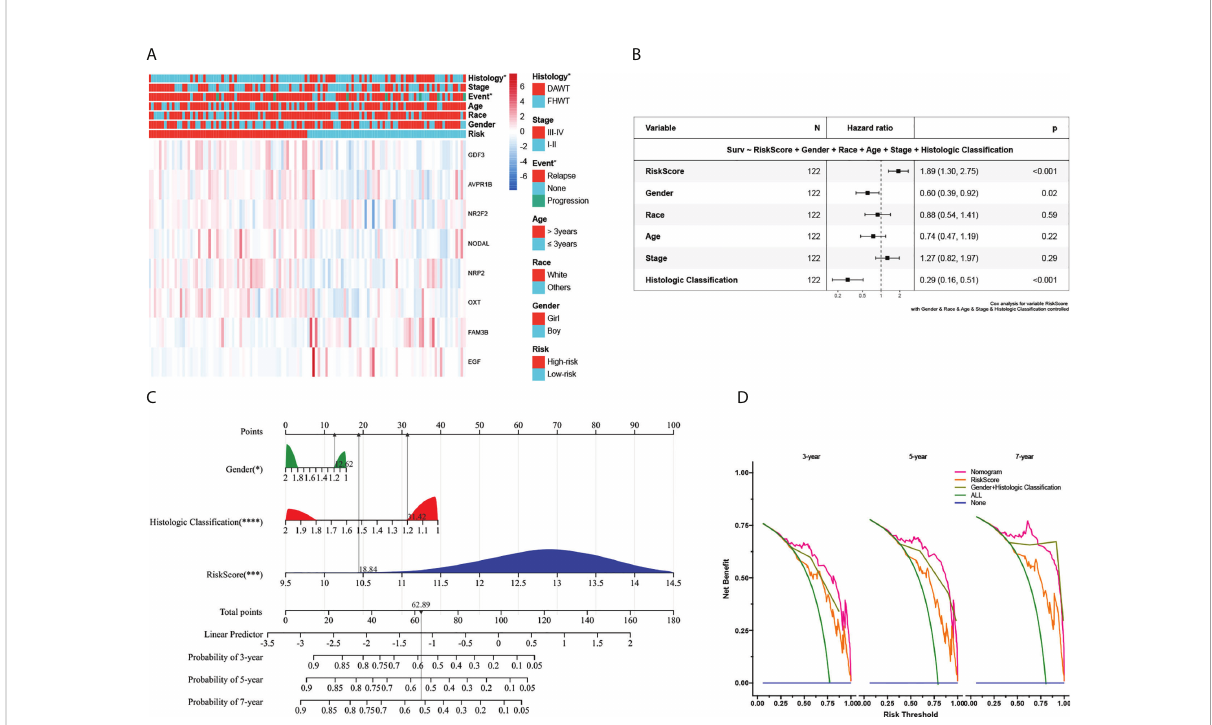
FIGURE 4 Association with clinicopathologic factors and construction of the nomogram and its accuracy veri fi cation. (A) Heatmap of the clinical relevance between the high- and low-risk subgroups in Wilms tumour. (B) The multivariate Cox regression analysis of risk factors in Wilms tumour. (C) The riskscore assessment nomogram to evaluate prognosis in Wilms tumour (3-, 5-, and 7-year survival rates). (D) On the x-axis, the calculated net bene fi t (y-axis) is displayed against the threshold probabilities of patients having 3-, 5-, and 7-year survival. The green line denotes the assumption that all patients have provided a survival time estimate. *, ***, and **** indicate a signi fi cance level of 0.05, 0.001, and 0.0001,